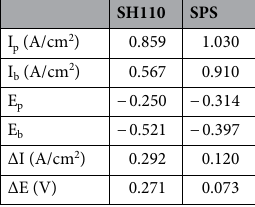
Table 1. Liner sweep voltammetry (LSV) results of SPS and SH110 electroplating solutions.